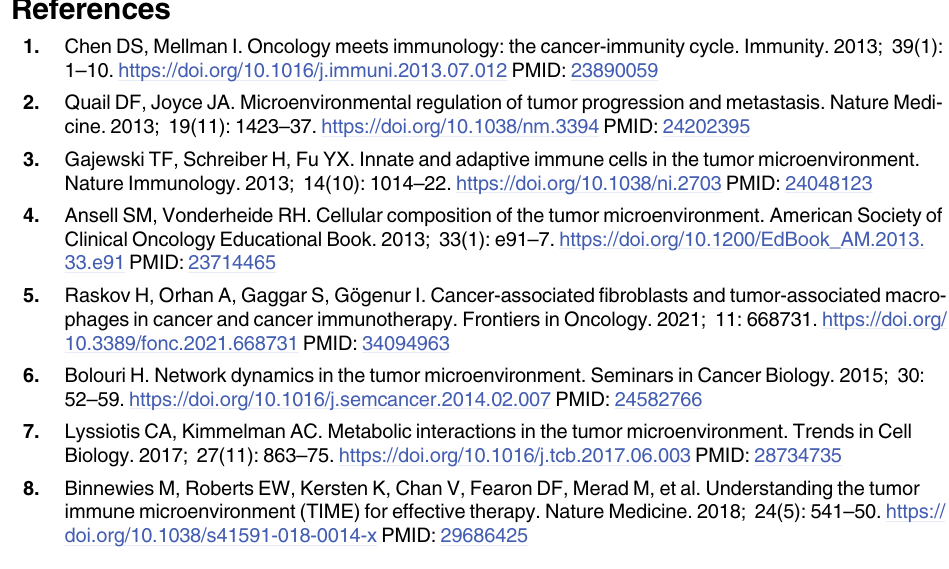
S6 Fig. Spatial representation of cancer cell subtypes in a section of a tumor slice with slow growth and R << 1. S1 Table. QSP model reactions, expressions, and parameter values after recalibration. S2 Table. Set of QSP parameters and ABM assumptions, parameters, and expressions used for the results presented in this